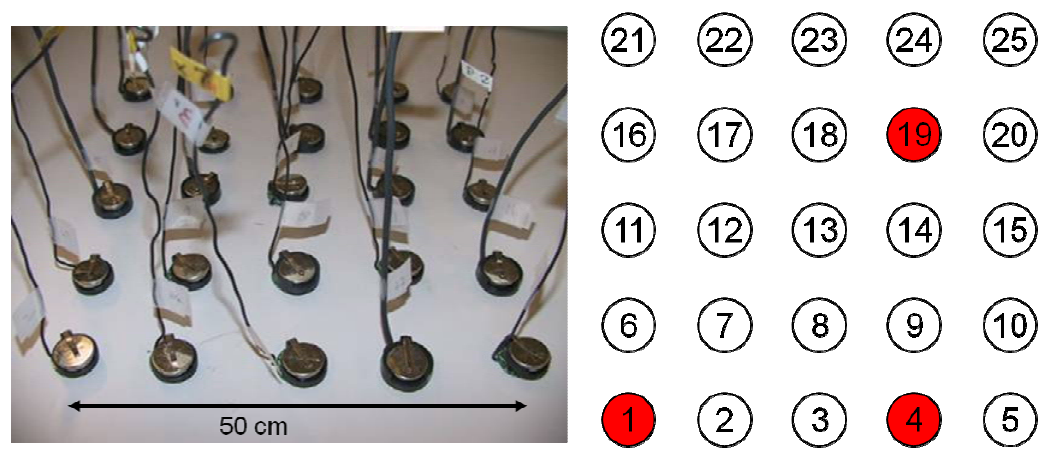
Figure 4. Distributed actuation experiment using